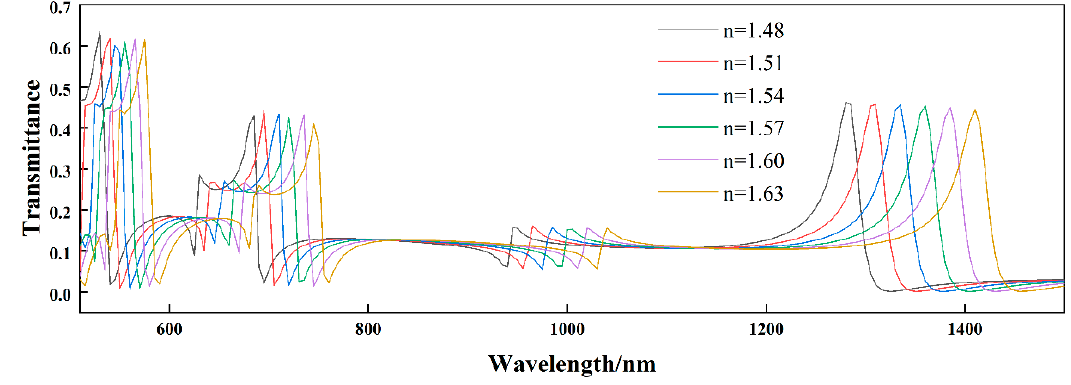
Figure 4. Influence of different refractive indices on the structural Fano resonances.